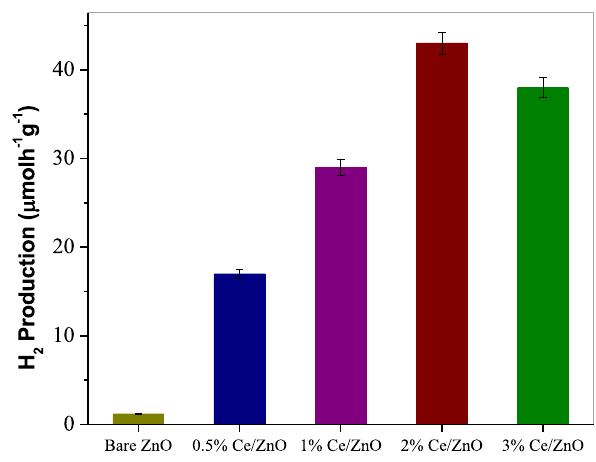
Fig. 1 Effect of extent of incorporation of Ce in ZnO on photocata- lytic H 2 production by means of decomposition of 10vol% methanol– water mixture